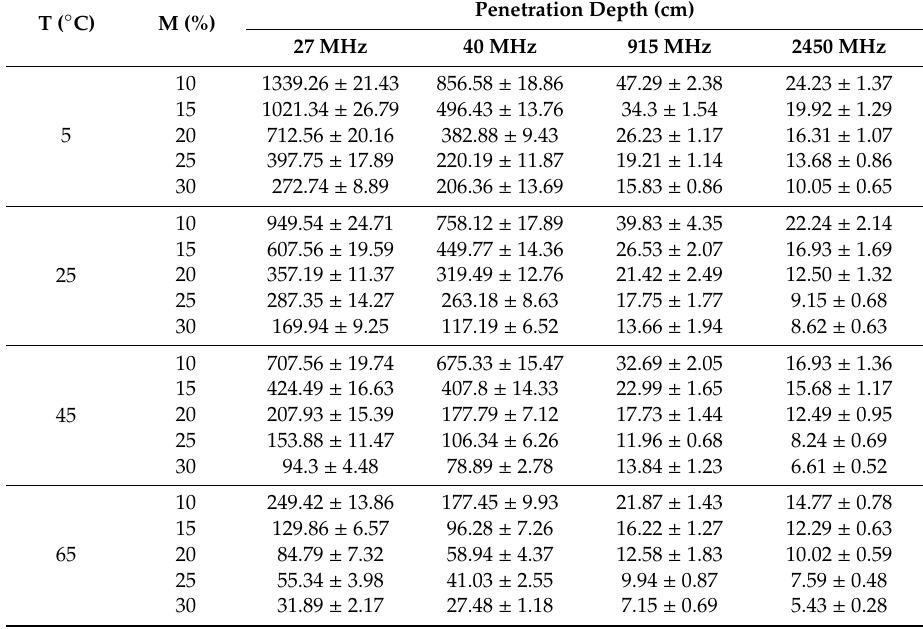
Table 8. Electromagnetic energy penetration depth for pecan nuts with di ff erent moisture contents.